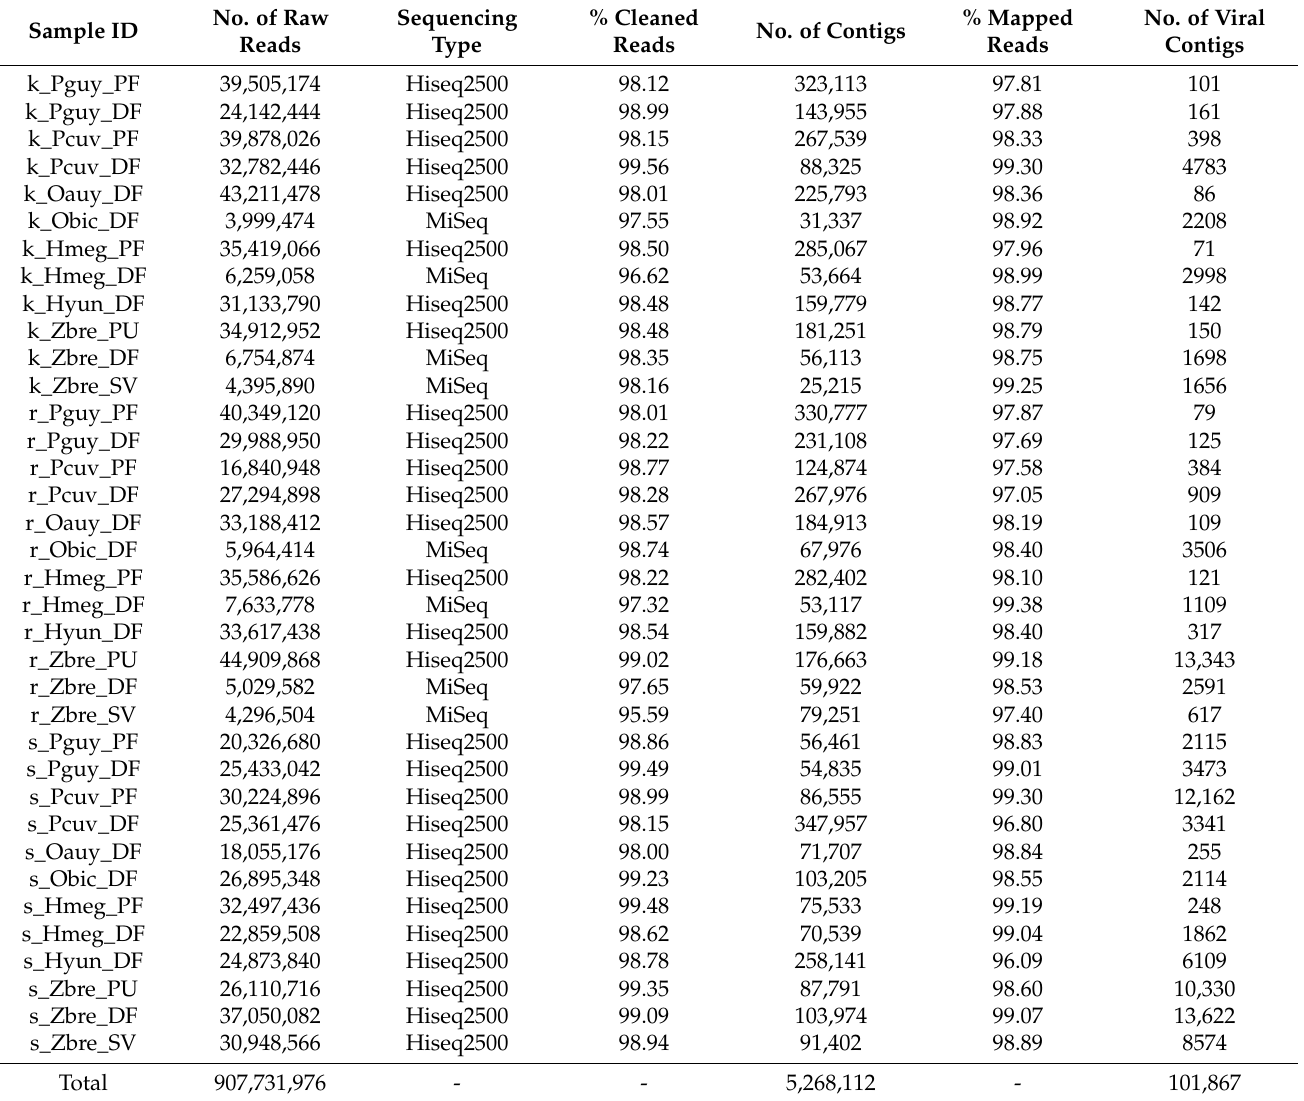
Table 2. Sequencing and bioinformatic processing data by organ, species, and habitat. It shows the number of raw reads, the corresponding Illumina Platform, the percentage of reads kept after trimming and cleansing, the number of assembled contigs, the percentage of cleaned reads mapped back to contigs, and the number of viral